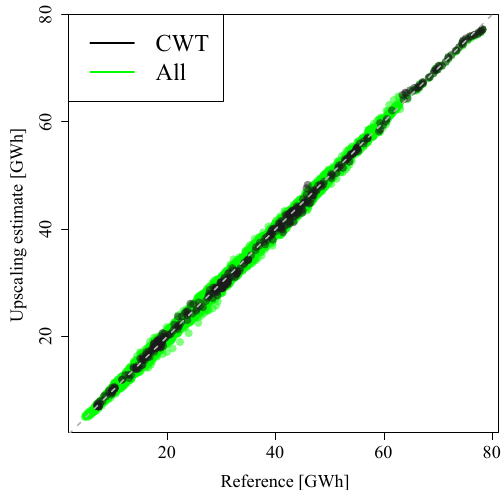
Figure 7. Time series of the upscaling estimate [GWh] versus the reference time series [GWh] for all time steps (green) and time steps with prevailing Southwesterly circulation